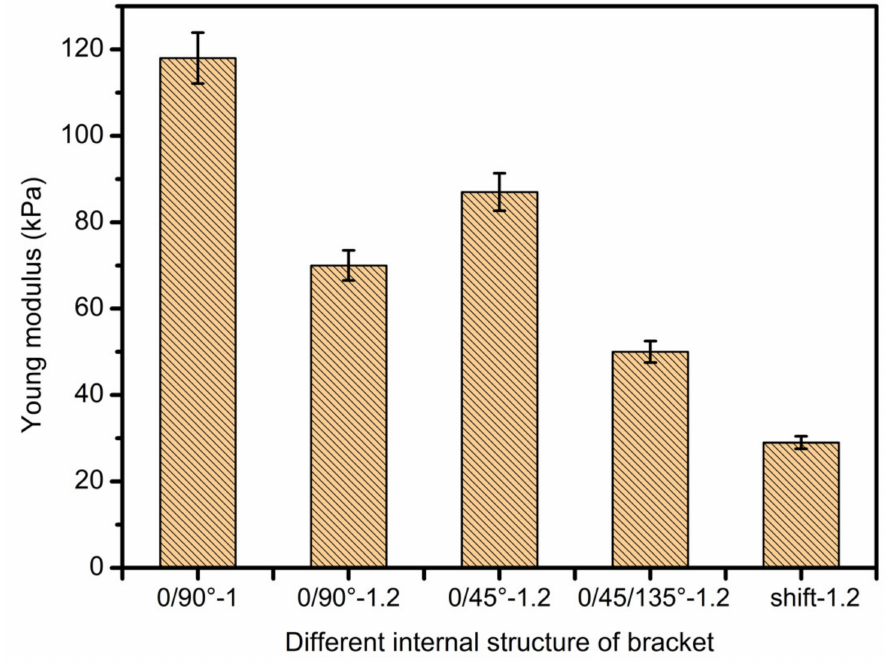
Figure 15. Young’s modulus diagram of sca ff olds with di ff erent internal structures.